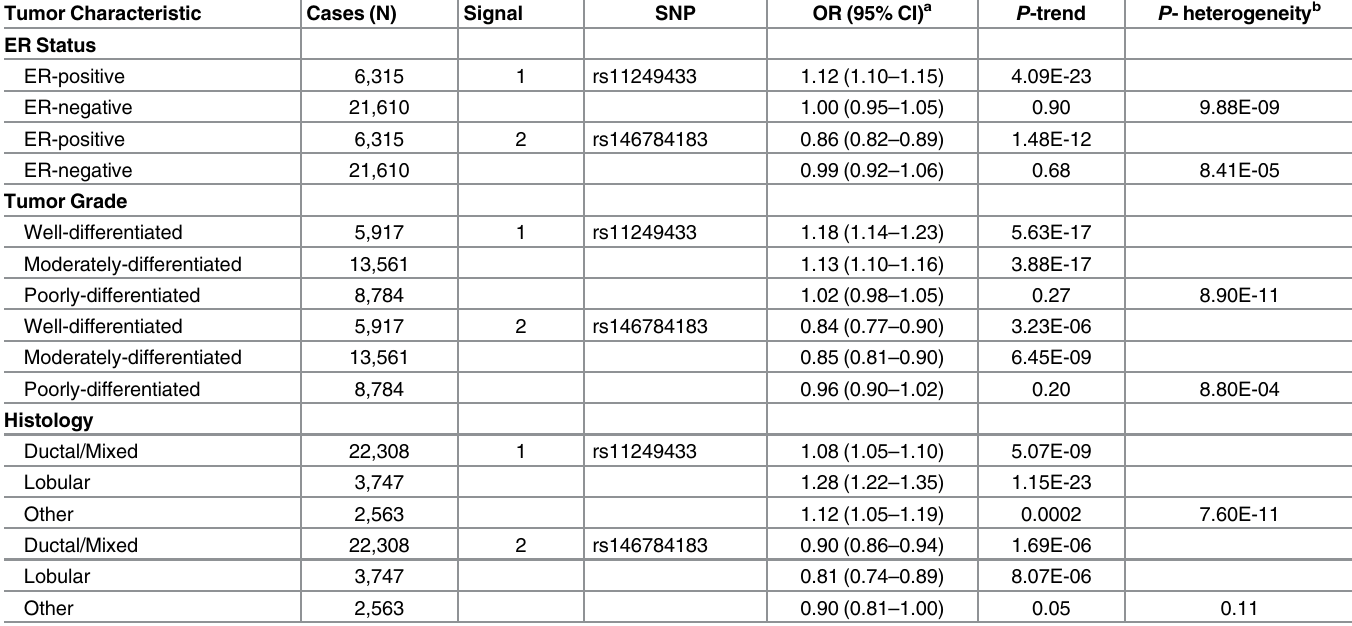
Table 2. Two independent association signals at the 1p11.2 locus: Association results for breast cancer risk among European women in BCAC, by tumor